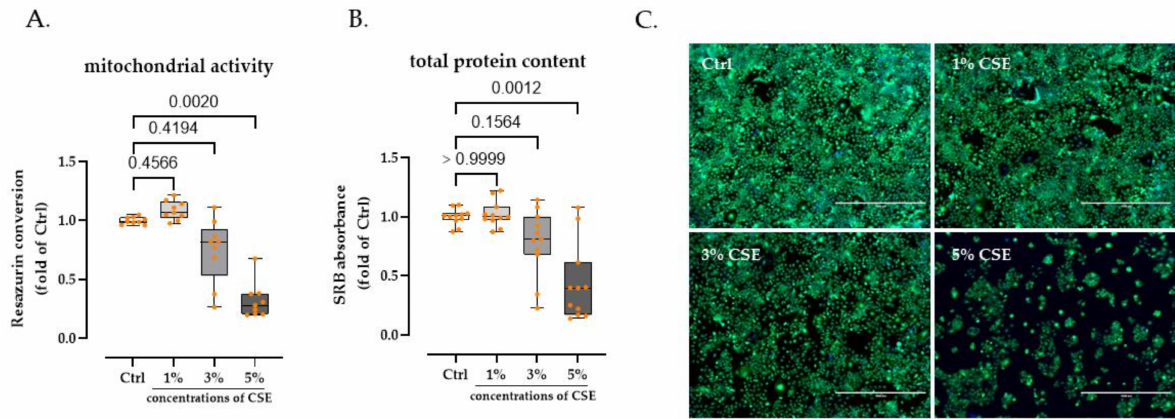
Figure 1. HaCaT cell viability exposed to CSE (0%, 1%, 3%, 5%); 1% and 3% of CSE did not significantly affect the viability, however 5% markedly reduced all three parameters. ( A ) Resazurin conversion was used to quantify cell numbers by mitochondrial activity after 72 h. ( B ) After 72 h, Sulforhodamine B (SRB) staining was used to quantify the total protein content of cells. N = 3, n = 3. The Kruskal–Wallis H test, followed by Dunn’s post-test, was used to determine statistical significance. ( C ) Representative fluorescent images. Calcein-AM (2 µ M, green) was used to visualize live